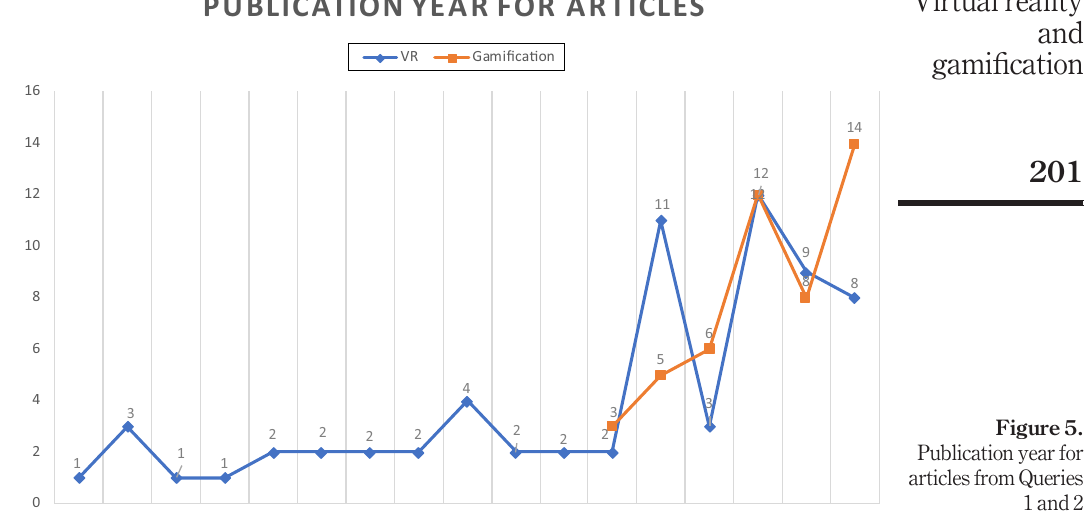
Figure 5. Publication year for articles from Queries 1 and